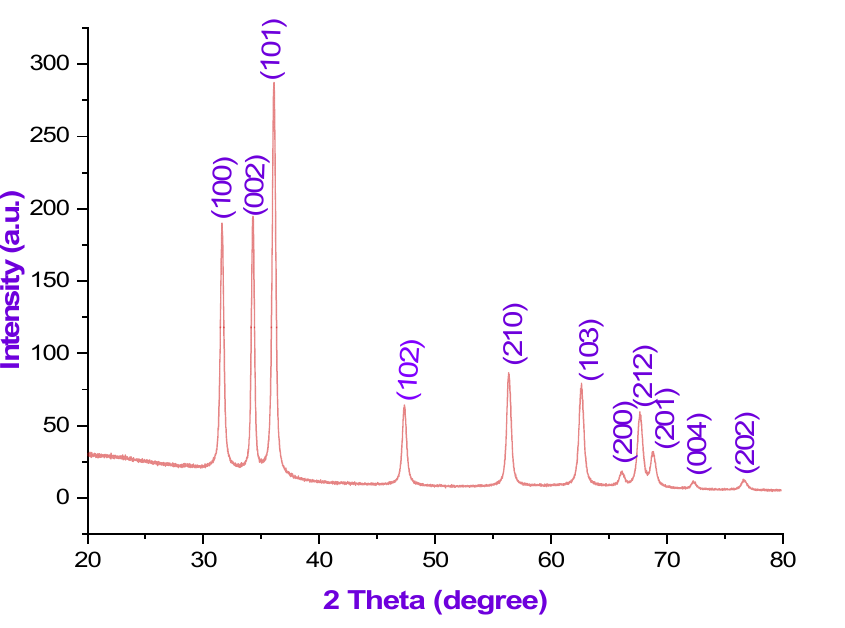
Figure 5. XRD spectrum of synthesized Er-ZnONPs.